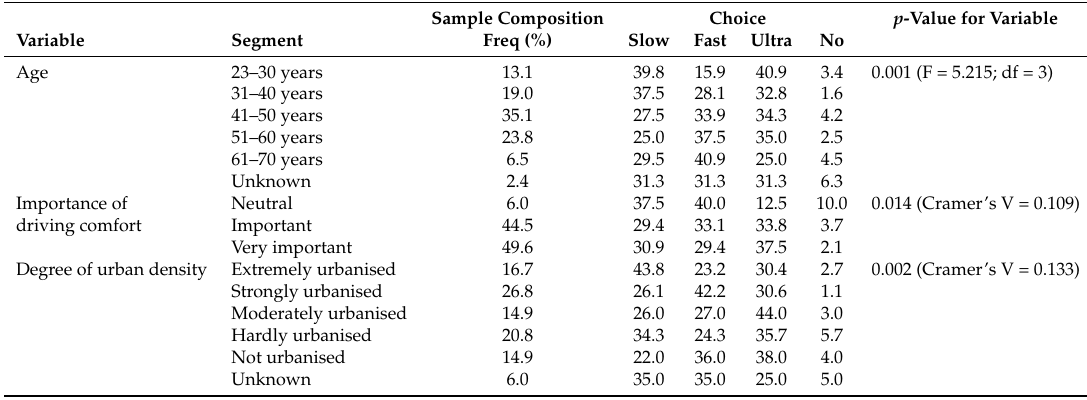
Table 3. Choices made per sample segment by age, importance of driving comfort and degree of urban density. These variables are significantly related to the choice